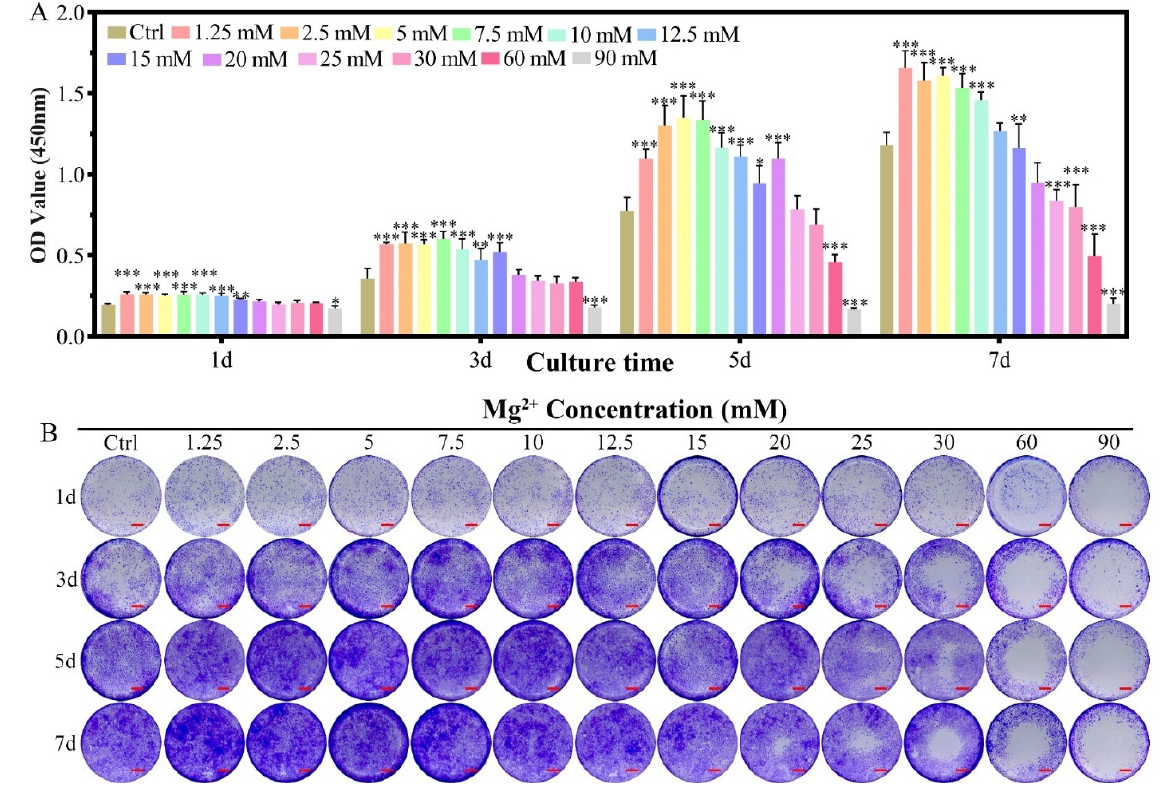
Figure 1. The proliferation of chondrocytes cultured in varied Mg 2+ concentrations from 0.7 mM (Ctrl group) up to 90.0 mM. ( A ) the CCK-8 quantitative method of the cell proliferation, all data were presented as mean ± SD, * p < 0.05, ** p < 0.01, and *** p < 0.001; ( B ) digital images of the crystal violet stained chondrocytes cultured in different Mg 2+ containing DMEM/F12 medium, scale bar = 1 mm.